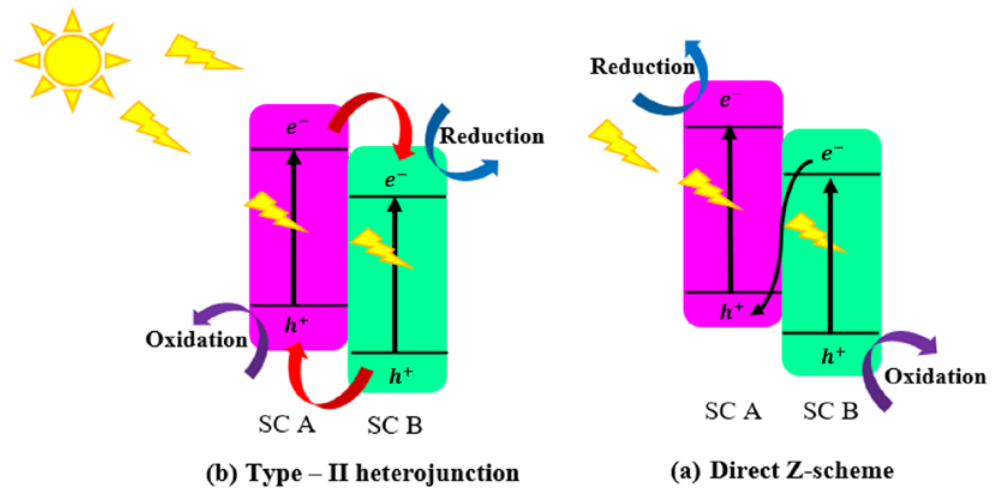
Figure 16. The schematic illustration and the correlation between the mechanism of charge-carrier separation in ( a ) Type-II heterojunction and ( b ) the direct Z-scheme.